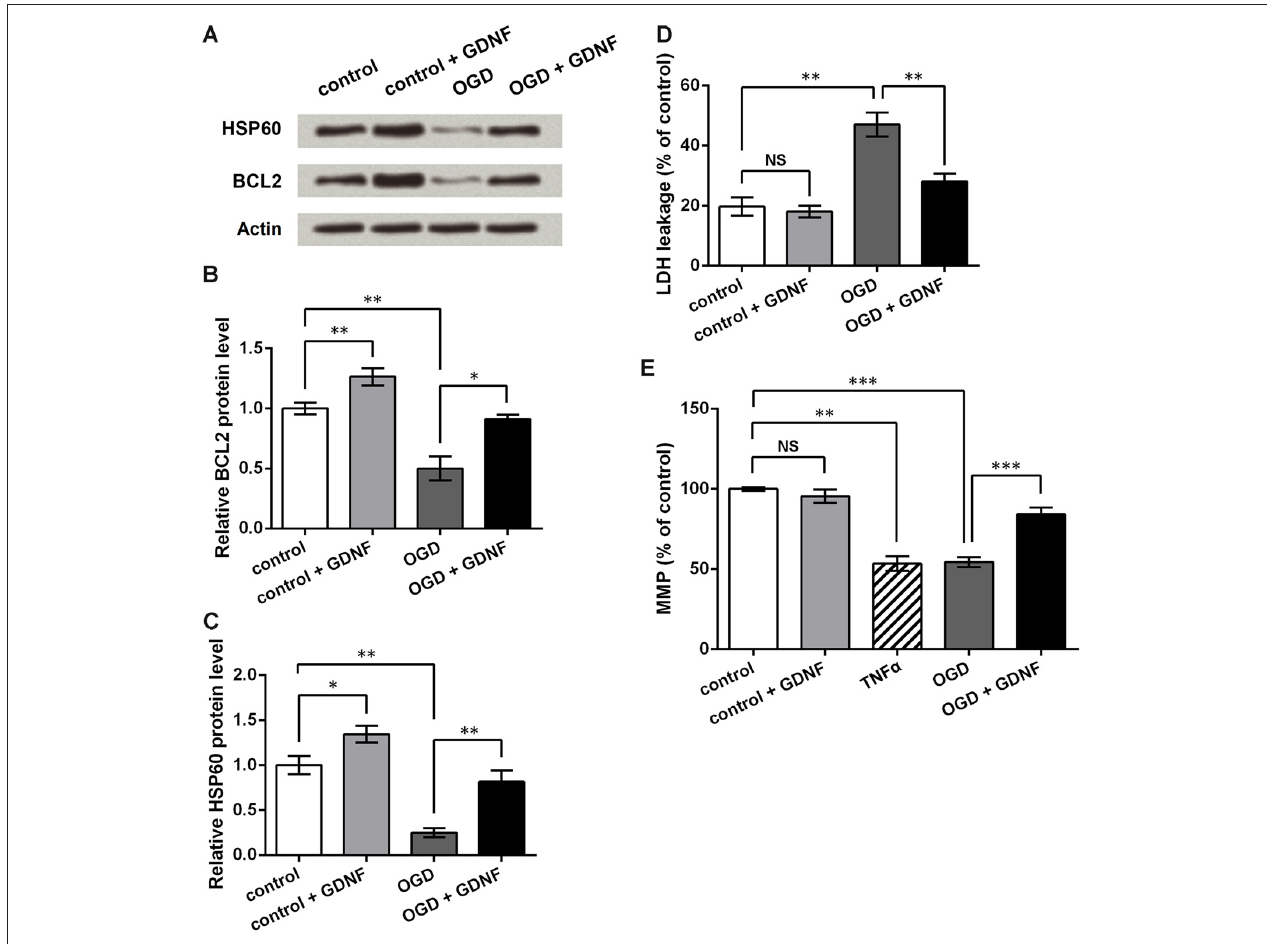
FIGURE 6 | GDNF helps to maintain mitochondrial membrane potential (MMP) and inhibit neuronal injury induced by OGD. (A) Western blot showing GDNF up-regulates B cell lymphoma 2 (BCL2) and heat shock 60 kDa protein 1 (HSP60) protein levels in neurons after OGD. Actin is used as an internal control. (B) Relative BCL2 protein level based on Western blot results. (C) Relative HSP60 protein level based on Western blot results. (D) Lactate dehydrogenase (LDH) assay indicates that GDNF inhibits neuronal LDH leakage after OGD. (E) MMP assay indicates that GDNF helps to maintain neuronal MMP after OGD, but TNF α decreases MMP. NS, not significant. ∗ P < 0.05. ∗∗ P < 0.01. ∗∗∗ P <